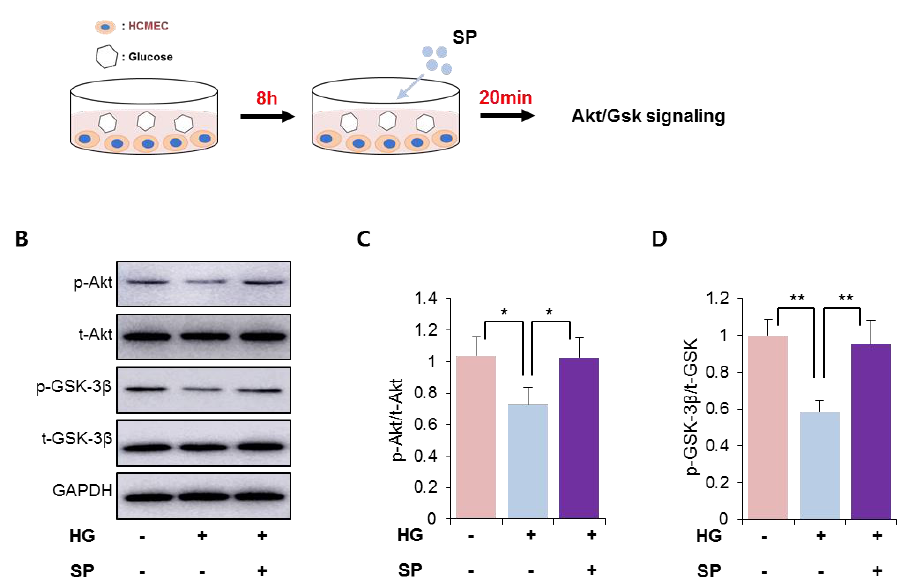
Figure 3. SP treatment activates PI3/Akt signaling in cardiac microendothelial cells exposed to HG. ( A ) Experimental scheme for glucose and SP treatment. ( B – D ) p-Akt and p-GSK- 3β were detected via western blotting and the expression level was quantified. Values of p < 0.05 were considered significant (* p < 0.05, ** p < 0.01, *** p < 0.001). The data are expressed as the mean ± standard deviation of three independent experiments. HG, high glucose; SP, substance-P; Akt, protein kinase B; p-Akt, phosphorylated Akt; t-Akt, total Akt; GSK-3 β , glucose synthase kinase 3 beta; GAPDH, glyceraldehyde-3-phosphate